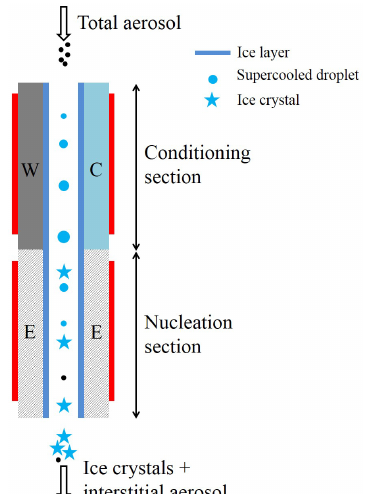
Figure 1. Schematic showing the geometry of the MCIC (expanded for clarity). INP proxies are activated to droplets within the condi- tioning section, and these supercooled droplets are steadily cooled within the nucleation section, from ≈− 20 to ≈− 42 ◦ C, to induce freezing of droplets and evaporate unfrozen supercooling droplets. The residence time in each section of the chamber is ≈ 5s, and the ice layer spans both sections of the chamber. A cyclone impactor upstream of the ice chamber is used to remove the larger particles ( > 1.5µm in diameter) while sampling airborne arable dust parti- cles. The heating tapes (red rectangular strip) are attached to the walls to precisely control the temperature of the walls. W: warm wall; C: cold wall; E: nucleation section wall. The length of both the conditioning and nucleation section is 0.45m. The width of the chamber is 0.15m. The gap between warm and cold walls is